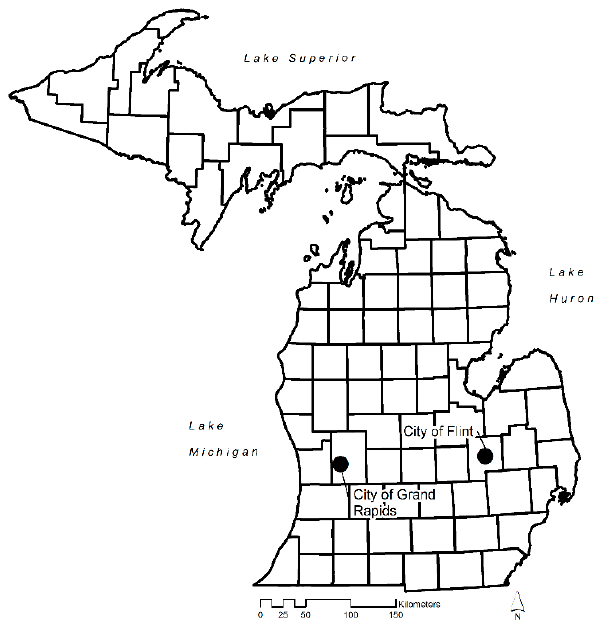
Figure 1. The State of Michigan and our two study cities: Flint and Grand Rapids.